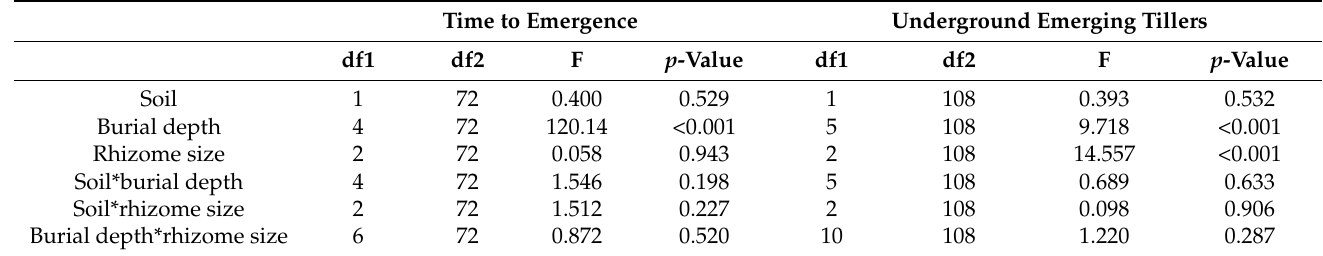
Table 2. Summary of ANOVA for all main effects and their interactions for the time of emergence of tillers and the underground emerging tillers of Cyperus aromaticus . Time to